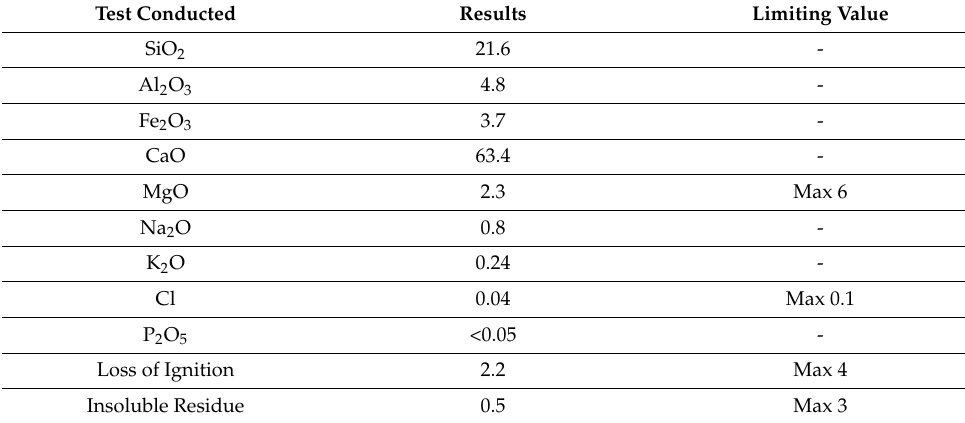
Table 2. Chemical Characteristics of